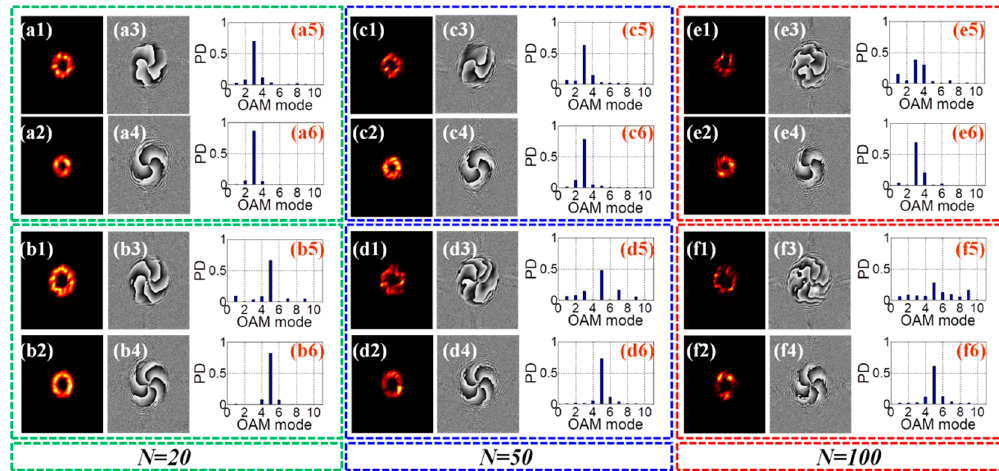
Figure 4. The intensity and phase distributions of OAM beams and their PD spectra without and with the pre-compensation of GS algorithm under simulated atmospheric turbulence with C 2 n valued as 1 × 10 − 14 m − 2/3 . The parts framed in green, blue and red dashes represent simulated turbulence channel with random phase-screen number of N = 20, 50 and 100 respectively. (a1, c1, e1) and (b1, d1, f1) are intensity profiles without pre-compensation for OAM beams with l = 3 and l = 5 respectively, (a3, c3, e3) and (b3, d3, f3) denote their corresponding phase distributions, (a5, c5, e5) and (b5, d5, f5) show their corresponding PD spectra; (a2, c2, e2) and (b2, d2, f2) are intensity profiles with the pre-compensation of GS algorithm for OAM beams with l = 3 and l = 5 respectively, (a4, c4, e4) and (b4, d4, f4) are their corresponding phases, (a6, c6, e6) and (b6, d6, f6) their corresponding PD spectra. Table 2. The PD values of OAM beams without (W/o) and with (W) GS algorithm corresponding to Figure 4.